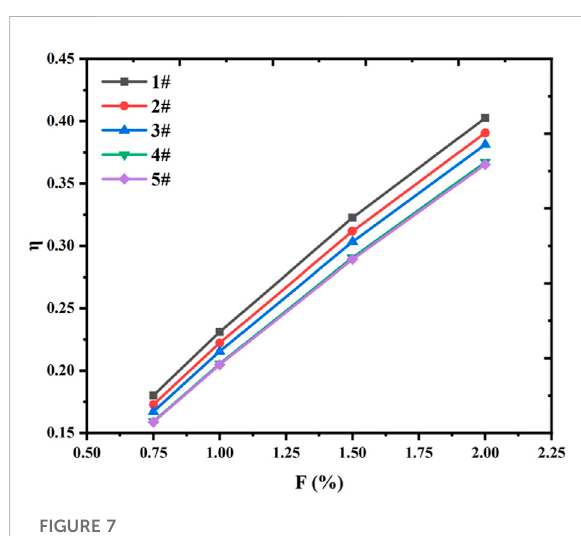
FIGURE 7 Cooling ef fi ciency for various coolant injection